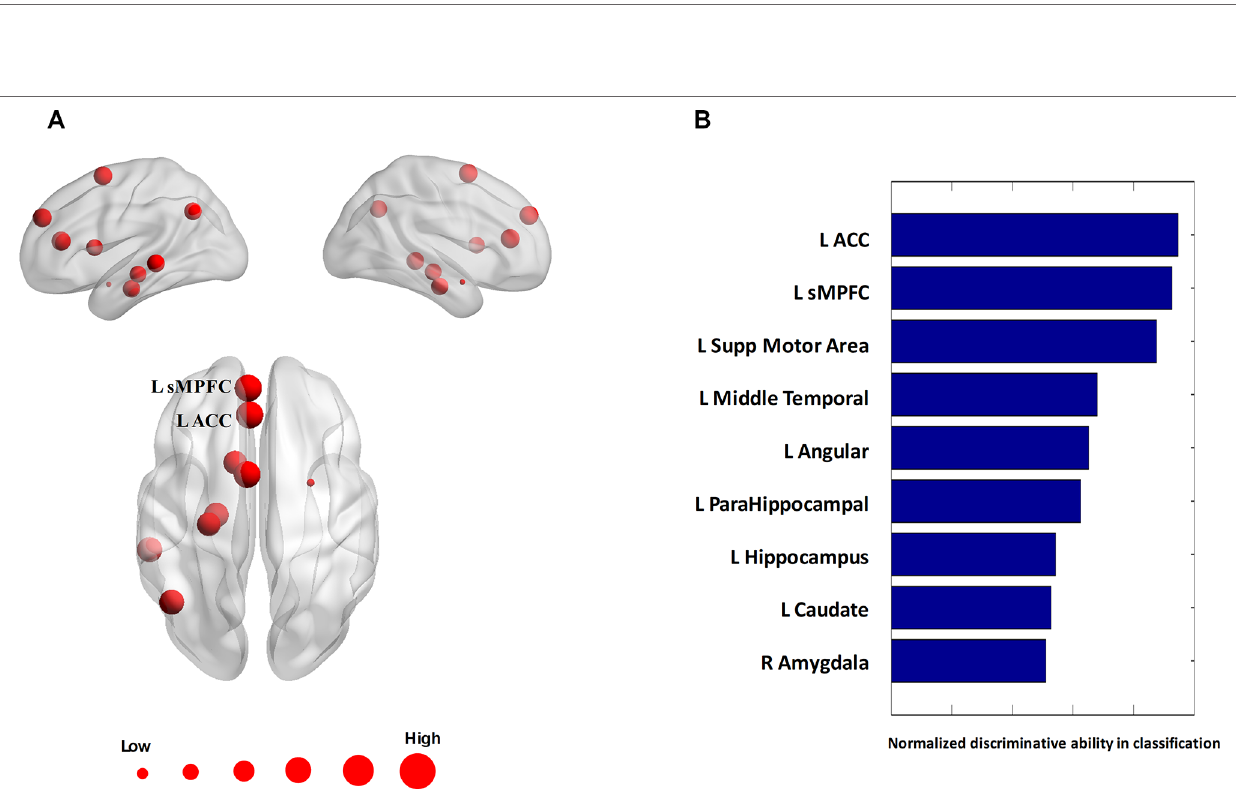
FIgURE 4 | Consensus nodes. (A) The spatial distribution of the consensus nodes, whose size was scaled according to their mean discriminative power in the tenfold cross-validation. (B) The normalized discriminative ability of the consensus nodes.